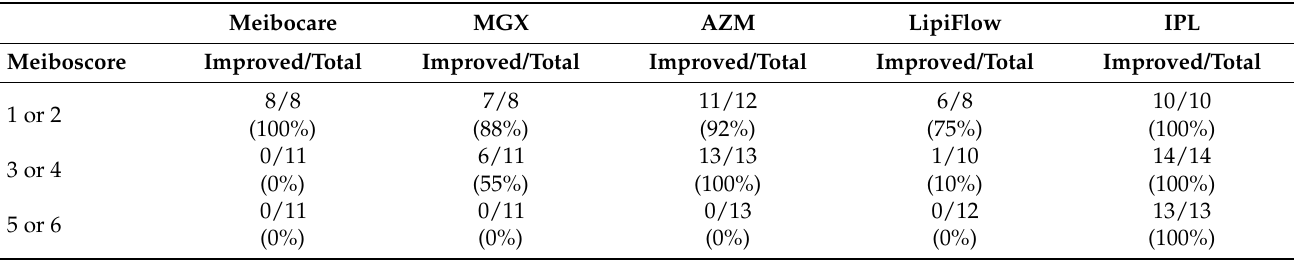
Table 4. Improvement of eyes with meibomian gland dysfunction after treatment in the meibocare, meibomian gland ex- pression (MGX), azithromycin eyedrop (AZM), LipiFlow, and intense pulsed light (IPL) groups according to the meiboscore at